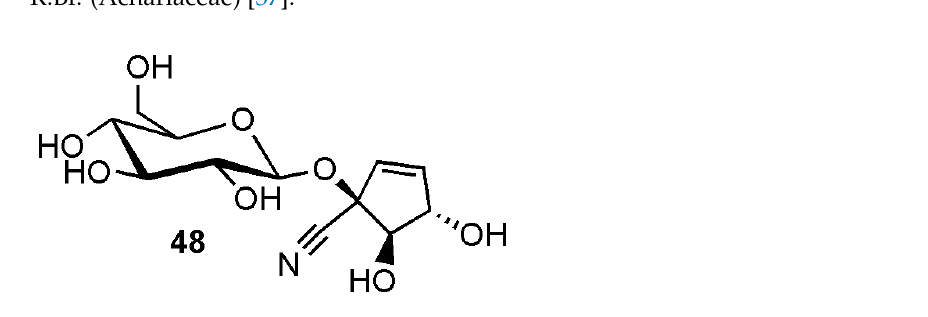
Figure 9. Cyanogenic glycosides group B-2, cyclopentene derivative with three hydroxygroups: (1 R ,4 S ,5 R )-gynocardin ( 48 ). Similar to the situation described above, compounds from Passiflora suberosa L.